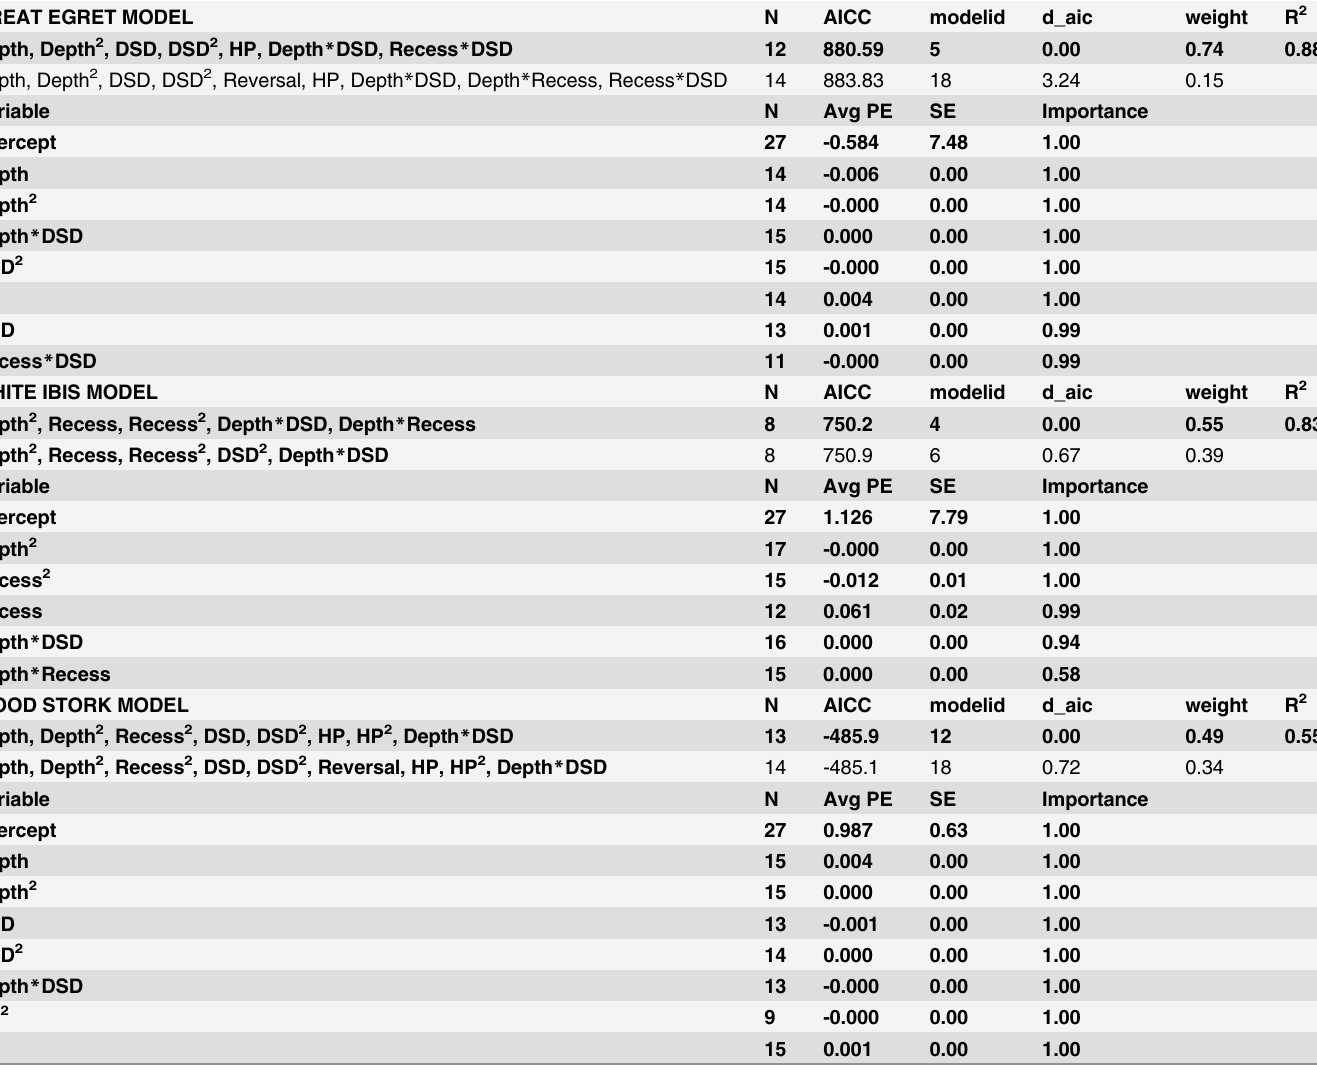
Models are ranked by differences in Akaike ’ s information criterion and only candidate models within Δ AIC cd (cid:3) 4.0 are presented. Model selection results are followed by model averaging results for each species. The R 2 represents the model fi t for the estimated spatial occurrence vs. model averaged predicted